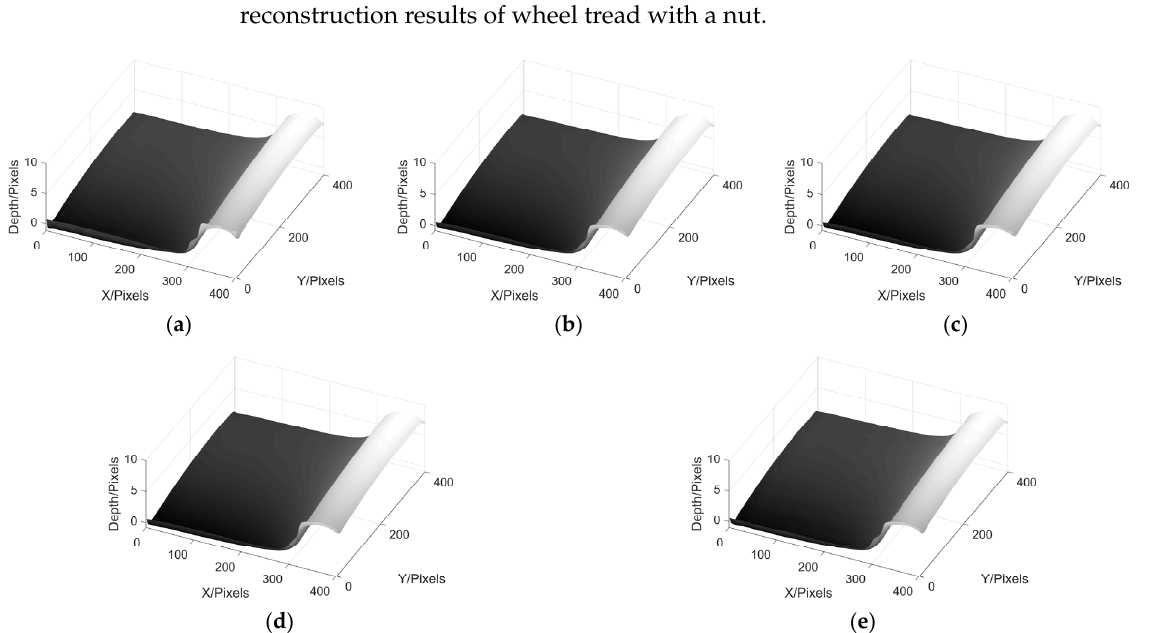
( e ) Figure 19. Phase reconstruction results of wheel tread with a nut using different filters. ( a ) MP based on Ideal low-pass; ( b ) MP based on Hanning; ( c ) MP based on Blackman; ( d ) MP based on Kaiser; ( e ) MP based on Hilbert transform. From the above results, it can be seen that in the experiment of wheel tread phase reconstruction, the 3D profile of the wheel tread can be well reconstructed by using these five filtering methods. In the experiment of phase reconstruction of wheel tread with a nut, the six corners of the nut can be seen clearly by the first four methods, but the edge of the nut cannot be seen in the result obtained by Hilbert transform. When there are many components in the spectrum of image, it becomes more difficult to use Hilbert transform to remove the DC component from the image. When conducting the MP experiment, it is